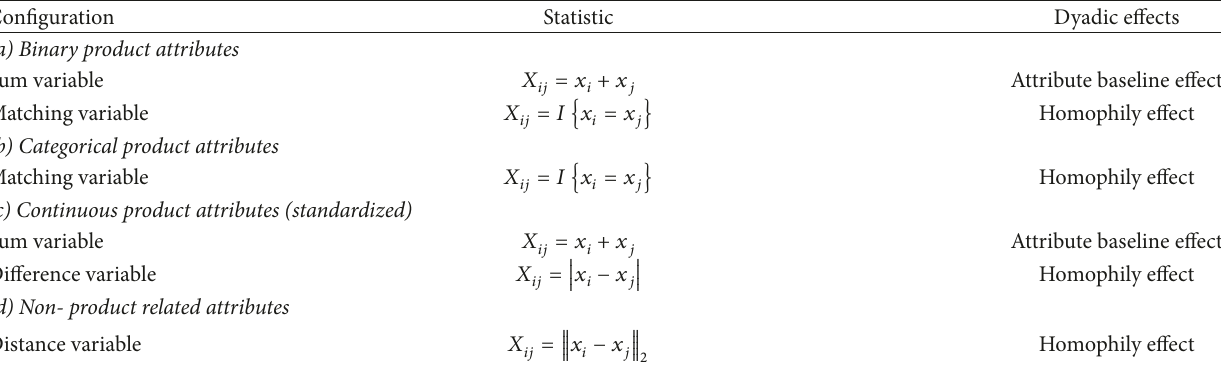
Table 1: Constructing explanatory dyadic